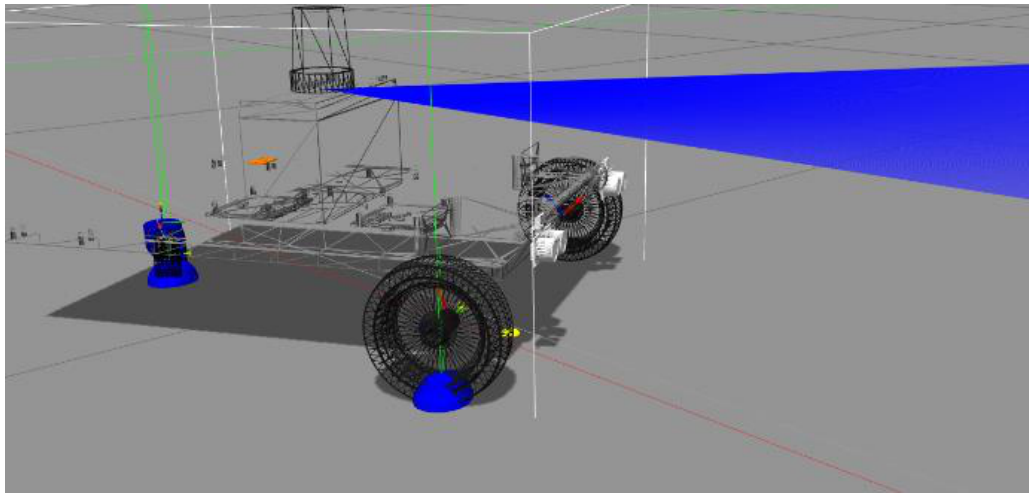
Figure III.1 Unisa-UGV 3D prototype Figure 3. Wheeled mobile robot 3D multibody model in the Gazebo